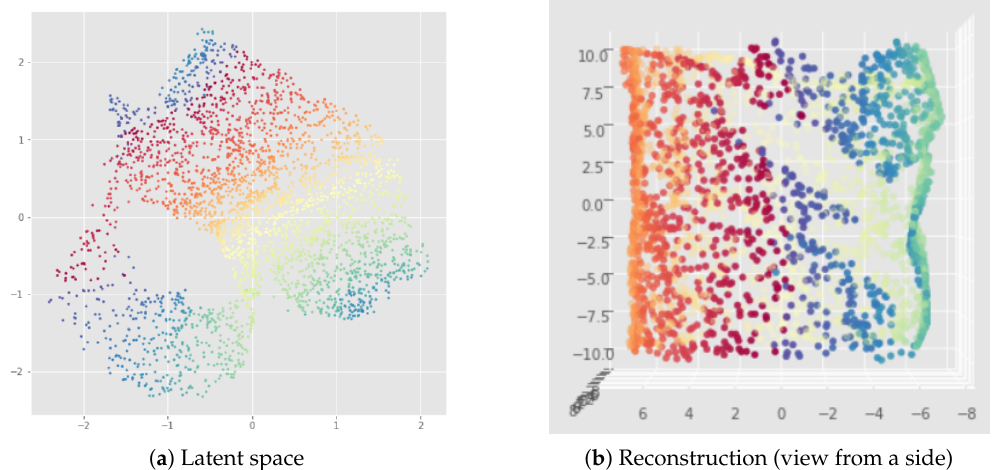
Figure 10. Latent representation (left) and reconstruction (right) of the Standard VAE applied to the open cylinder-pytorchseed = 2, trained for 500 epochs. We can see that for the latent representation ( a ) we have β 1 = 1 like to the original open cylinder dataset. However we can see three distinct parts for the blue region which is problematic if we want to interpolate in this region in the latent space, and as we can see in the reconstruction ( b ) it implies discontinuities in the blue region of the reconstructed